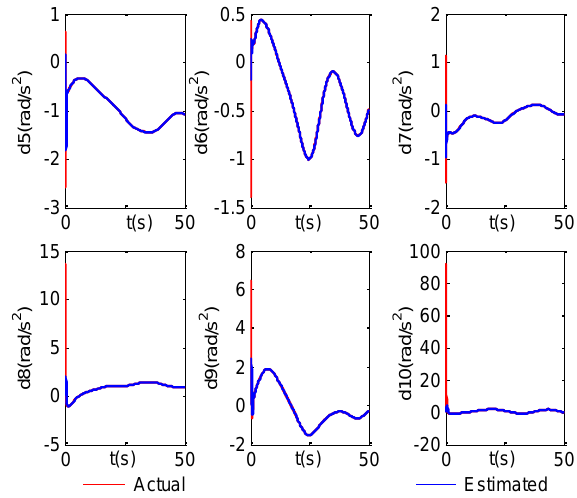
Figure 31. d5 − d10 and their estimations (case 4). Table 7. Average estimation errors of the lumped disturbances under four cases from 10 s to 50 s.